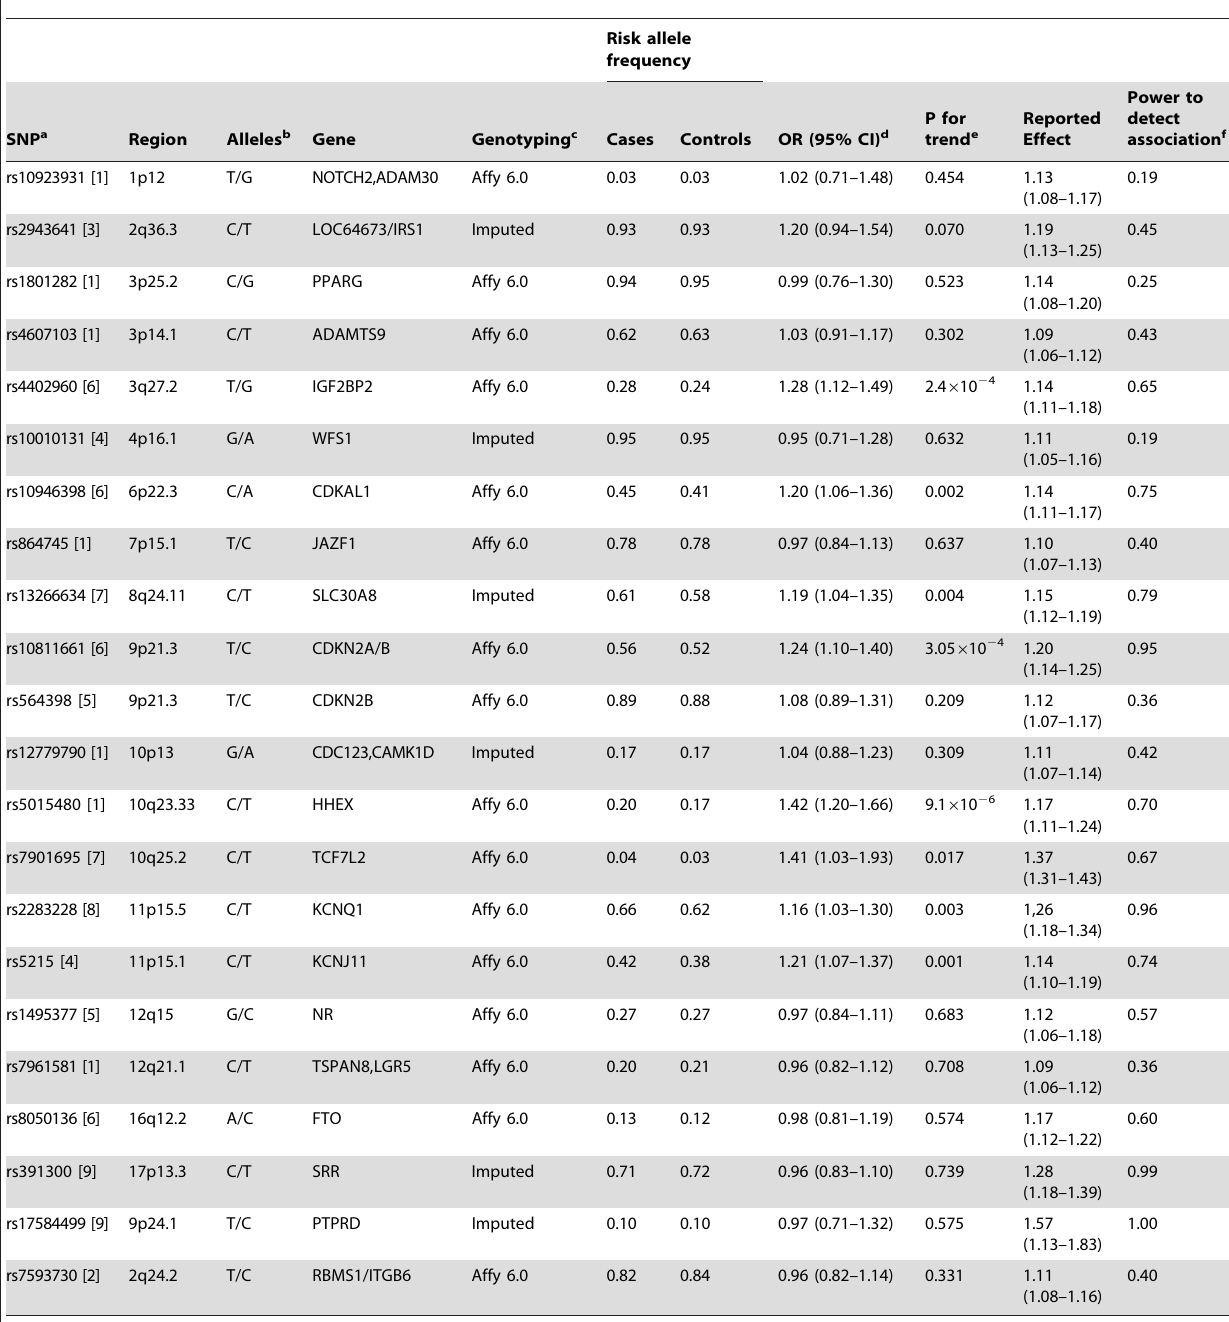
Table 2. Associations of previously-reported T2D related SNPs with disease risk in Chinese women.